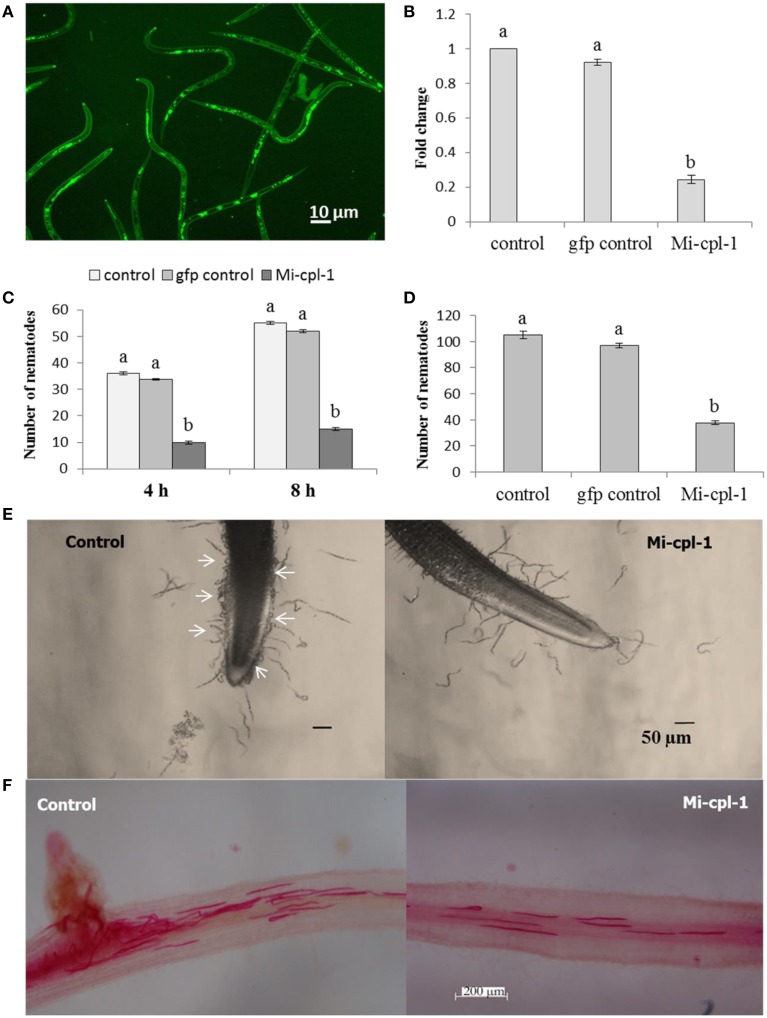
Effect of in vitro RNAi of Mi-cpl-1 in M. incognita J2. (A) Fluorescence microscopy showing the ingestion of FITC in M. incognita J2 after 6 h treatment with octopamine (50 mM) in soaking buffer. (B) Real-time PCR analysis of Mi-cpl-1 transcript abundance. Expression was quantified as fold change values calculated by 2-ΔΔCT method. (C) Attraction of J2s to tomato root tip at different time points (4 h and 8 h) in pluronic gel. (D) Nematode penetration of tomato root after 24 h. (E) Attraction assay in pluronic gel. Arrows indicate control J2s were attracted in greater number toward tomato root tip compared to dsRNA fed J2s. (F) Invasion of M. incognita J2 inside tomato roots after 24 h. Tomato roots supported less number of dsRNA treated J2s compared to control (Scale bar = 200 μm). Nematodes were stained with acid fuchsin (Byrd et al., 1983). Control-treatment with soaking buffer alone; gfp control-treatment with soaking buffer containing 1 mg ml−1
gfp dsRNA; Mi-cpl-1-treatment with soaking buffer containing 1 mg ml−1
Mi-cpl-1 dsRNA. Each bar represents the mean ±SE of n = 3, and bars with different letters denote a significant difference at P < 0.05.